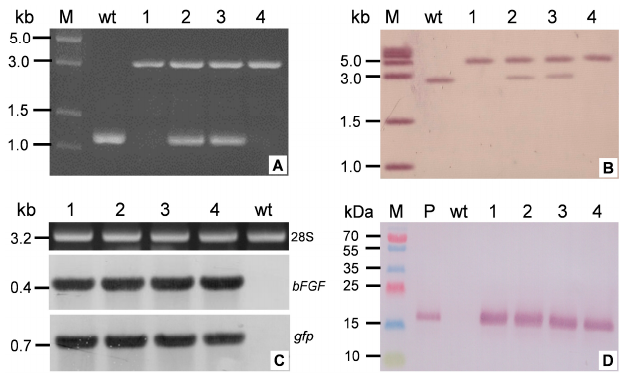
Figure 3. Molecular testing of T 0 transplastomic plants. ( A ) PCR analysis of integration of the expression cassette into transgenic plants. M, DNA molecular marker; Lanes 1–4: T 0 putative transgenic plants; ( B ) Southern blot analysis. M, DNA molecular marker; Lanes 1–4: the leaves of T 0 putative transgenic plants. The single 4.7 kb band in lanes 1 to 4 indicated homoplastomic status due to the insertion of foreign expression cassette, whereas lanes 2 and 3 with an additional ~2.5 kb band, amplified from wild-type plants, indicating heteroplastomic status; ( C ) Northern blot analysis for bFGF (middle) and gfp (bottom) mRNAs. The ethidium bromide-stained gel of 28S band of total RNA is shown in the top as a loading quantitative control. wt is untransformed tobacco as negative control; ( D ) Western blot for determining the expression of bFGF in T 0 transplastomic plants. Expression of bFGF (17 kDa) is observed in the leaves of four transgenic plants (lanes 1–4), but absent in the leaves of a wild-type plant (wt). Commercial bFGF protein (P) served as positive control. M is protein marker.